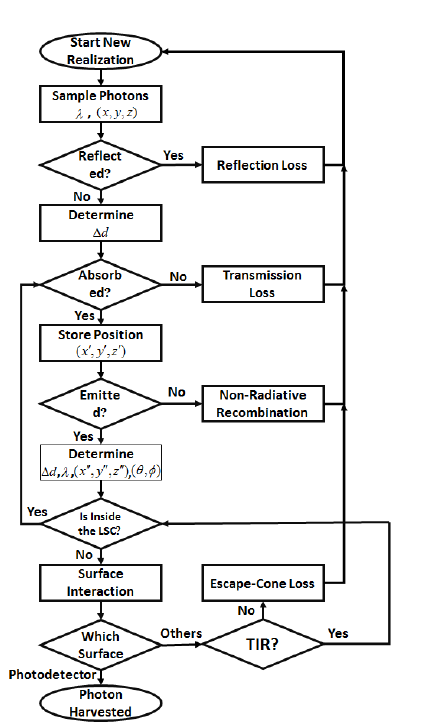
Figure 4. Monte Carlo ray-tracing algorithm that applied for numerical simulation.